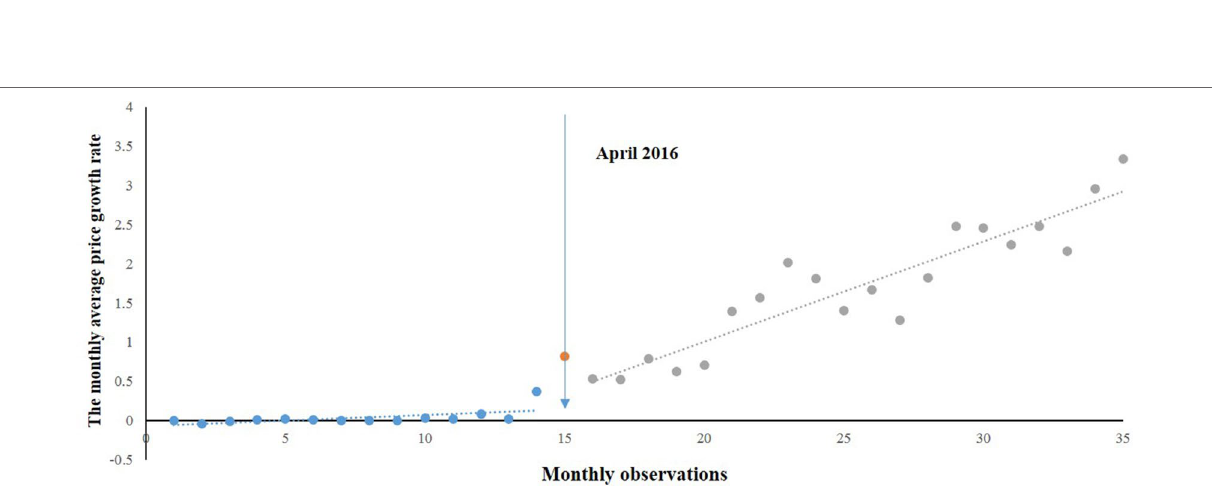
FIGURE 1 | The trend in the monthly average price growth rate of paediatric, gynaecological and emergency medicines in Shaanxi Province from 2015 to 2017.